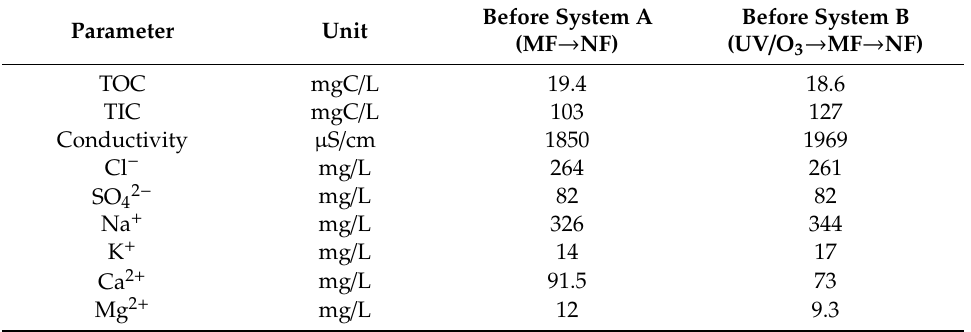
Table 2. Composition of laundry wastewater after biological treatment applied as a feedstock stream in systems A and B.